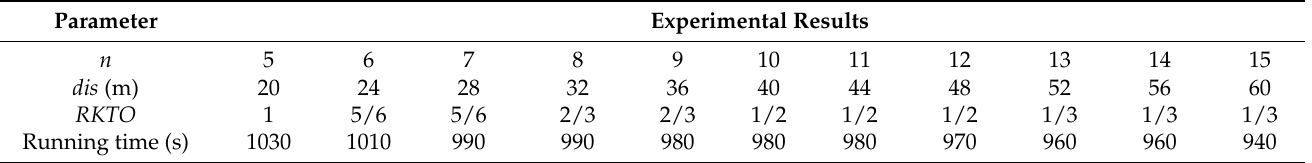
Table 4. Trajectory rarefying threshold test